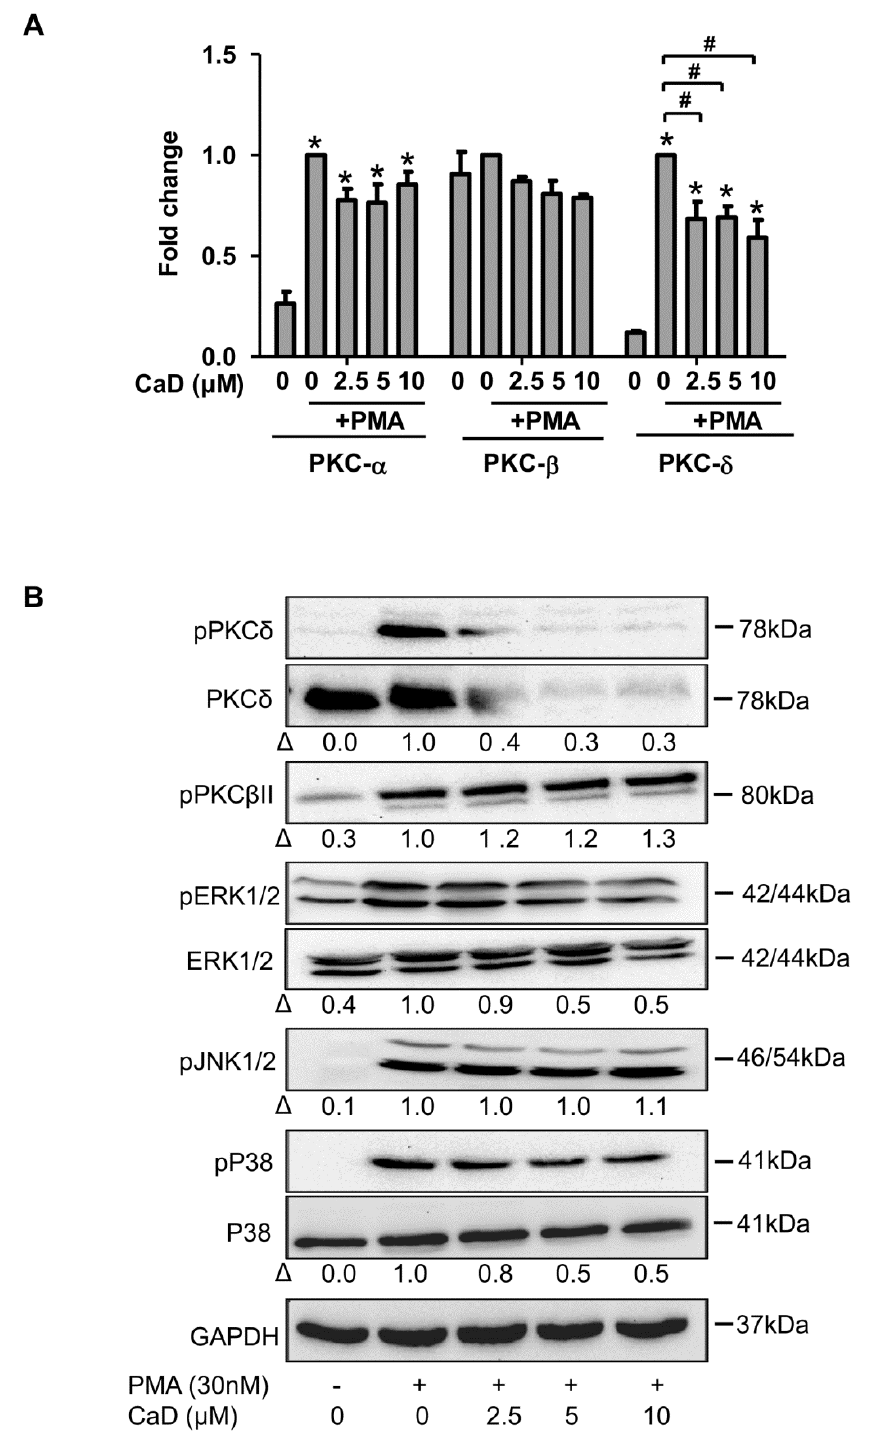
Figure 5. Effect of CaD on PKC δ -MAPK signaling during PMA-induced monocyte-to-macrophage differentiation. THP-1 monocytes were pretreated with various concentrations (0–10 µ mol/L) of CaD for 1 h, followed by PMA treatment for 24 h ( A ) or 30 min ( B ). PKC α , PKCßII, and PKC δ transcript levels ( A ) were measured by quantitative RT-PCR, and phosphorylation of PKC and MAPK pathway components ( B ) was measured by Western blotting. ∆ , fold-change normalized to PMA only ( n = 3, mean ± SEM. * p < 0.05 vs. no treatment, # p < 0.05 vs. PMA only, one-way ANOVA). The Western blots represent one from at least three independent experiments.